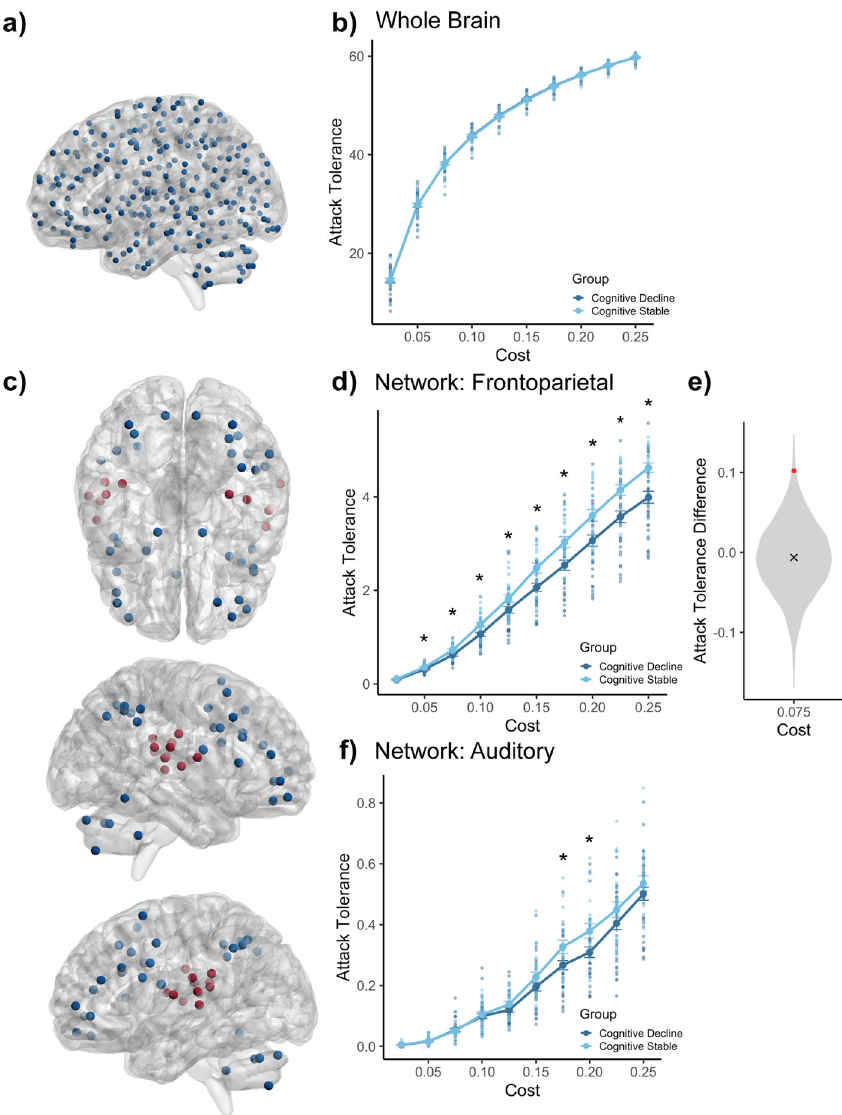
Fig. 2 Targeted-attack analyses. Attack analyses were performed on thresholded matrices. a A cortico-subcortical network parcellation composed of 300 nodes was used . b Whole-brain targeted attacks. There were no signi fi cant differences in attack tolerance between groups across all costs examined (random-permutation test, all p -values > 0.66). c Nodes included in each network examined. Blue and red nodes correspond to the frontoparietal network and the auditory network, respectively. d Frontoparietal network targeted attacks. The cognitive-decline group displayed signi fi cantly reduced attack tolerance relative to the cognitively stable group across nine of the 10 costs examined (random-permutation test, p -value = 0.07 for cost 2.5%, otherwise all p -values < 0.028). e Distribution of cognitively stable – cognitive decline attack-tolerance differences at one representative cost obtained from randomized null graphs of the same size as the frontoparietal network. Hashmark denotes the average difference from this distribution, red point indicates true difference ( p -value = 0.007). f Auditory network targeted attacks. There were signi fi cant differences between groups in only two of the costs examined (random-permutation test, p -values < 0.02 for costs 17.5 and 20%, otherwise, all p -values > 0.13). See Supplementary Tables 3, 4, 6, and 8 for complete summaries of statistics. Comparisons reported here are between n = 37 cognitively declining individuals and n = 22 cognitively stable individuals. Error bars depict SEM and asterisks indicate signi fi cance, p <